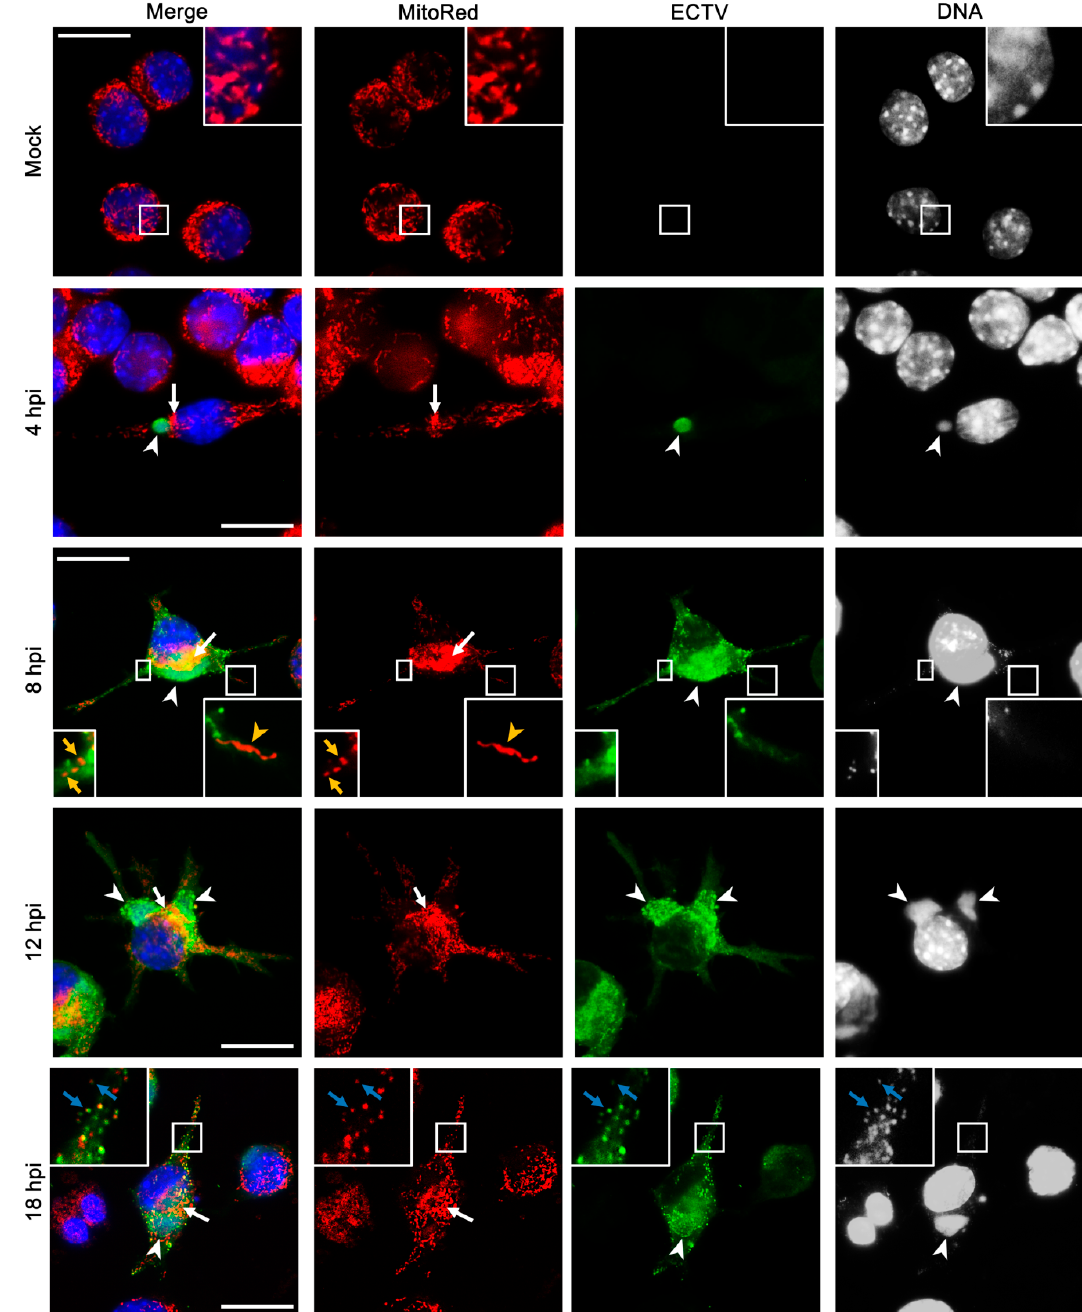
Figure 3. Mitochondrial network morphology in RAW 254.7 cells during ECTV infection. White arrows indicate mitochondria accumulated in close proximity to viral factories. White arrowheads indicate viral factories. Yellow arrows indicate fragmented mitochondria in cytoplasmic projection. Yellow arrowheads indicate elongated mitochondria in cytoplasmic projection. Blue arrows indicate fragmented, punctate mitochondria co-localized with progeny virions. Scale bar: 10 µm.